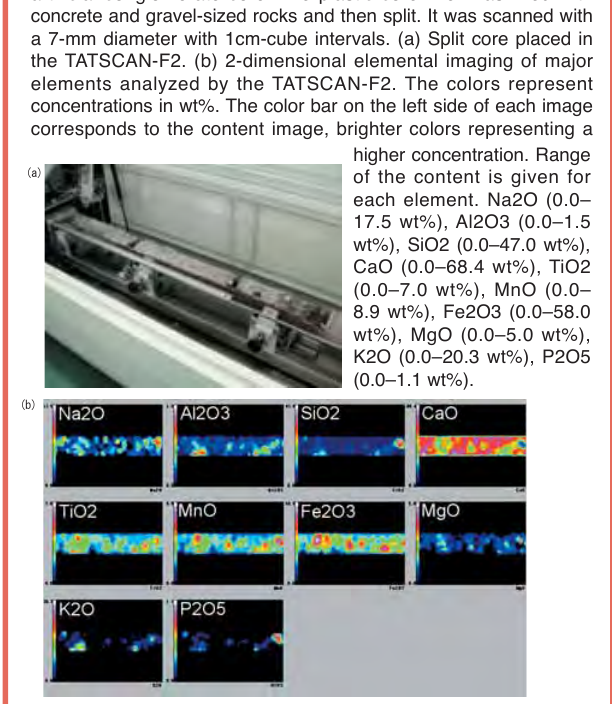
Figure 4. Example of core images using the TATSCAN-F2 with an artificial conglomerate core. The plastic core liner was filled with concrete and gravel-sized rocks and then split. It was scanned with a 7-mm diameter with 1cm-cube intervals. (a) Split core placed in the TATSCAN-F2. (b) 2-dimensional elemental imaging of major elements analyzed by the TATSCAN-F2. The colors represent concentrations in wt%. The color bar on the left side of each image corresponds to the content image, brighter colors representing a higher concentration. Range of the content is given for each element. Na2O (0.0– 17.5 wt%), Al2O3